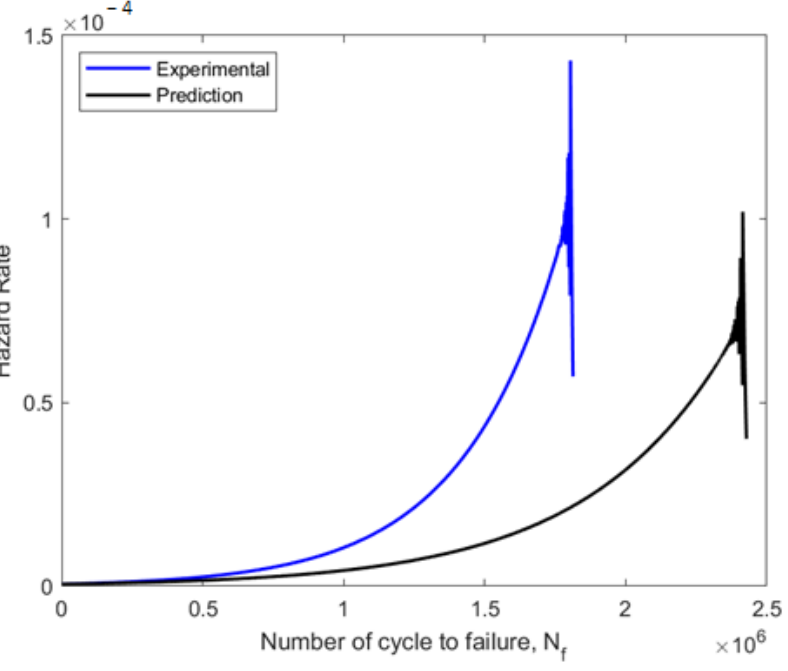
Figure 16. Weibull distribution for hazard rate curve for experimental and predicted data on fa- tigue.